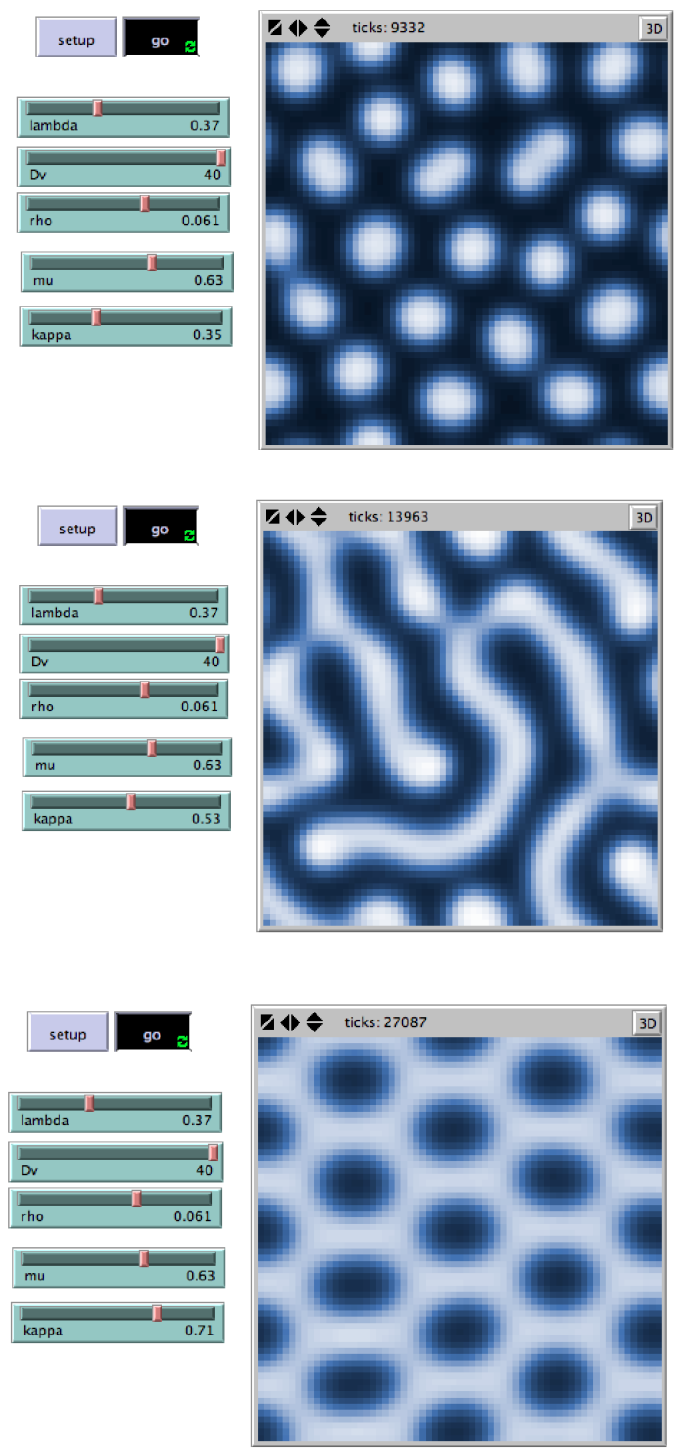
Figure 6. Turing patterns in reaction–diffusion MCNN. When the parameter, k , is changed, different patterns are obtained.